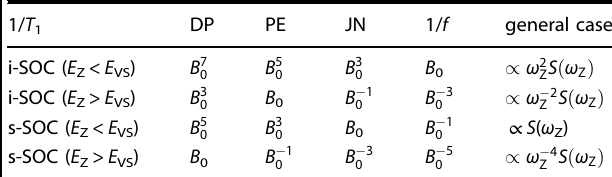
Table 1. Magnetic fi eld dependences of spin relaxation for different noises and SOC. Spin relaxation rate 1/ T 1 versus the magnetic fi eld B 0 due to DP phonon, piezoelectric (PE) phonon, Johnson noise (JN), or 1/ f charge noise via the i-SOC or the s-SOC (at zero-temperature limit). S ( ω Z ) is the power spectral density of electric fi eld, ω Z = g μ B B 0 / (cid:2) h is the Larmor